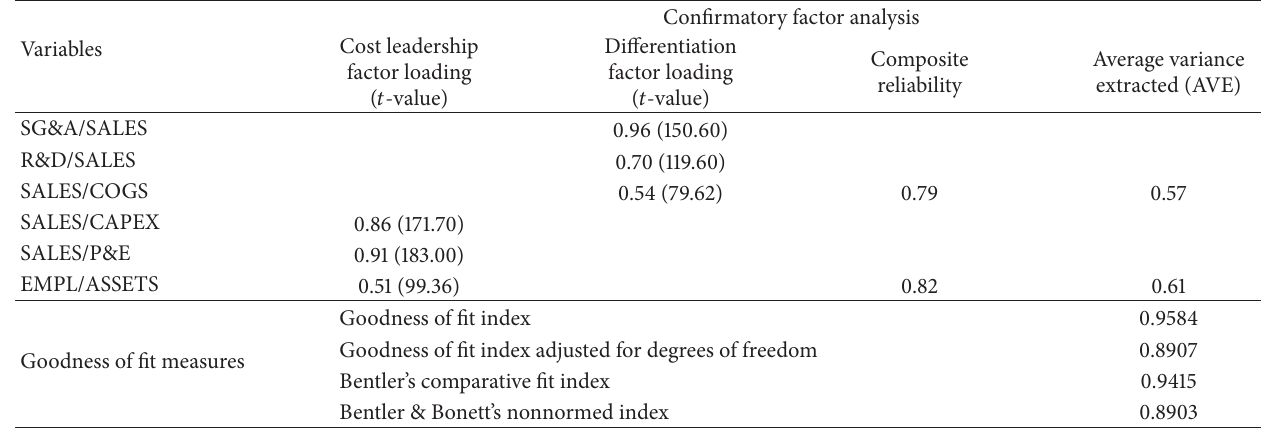
Table 1: Factor analysis to confirm strategy constructs ( 𝑁 =